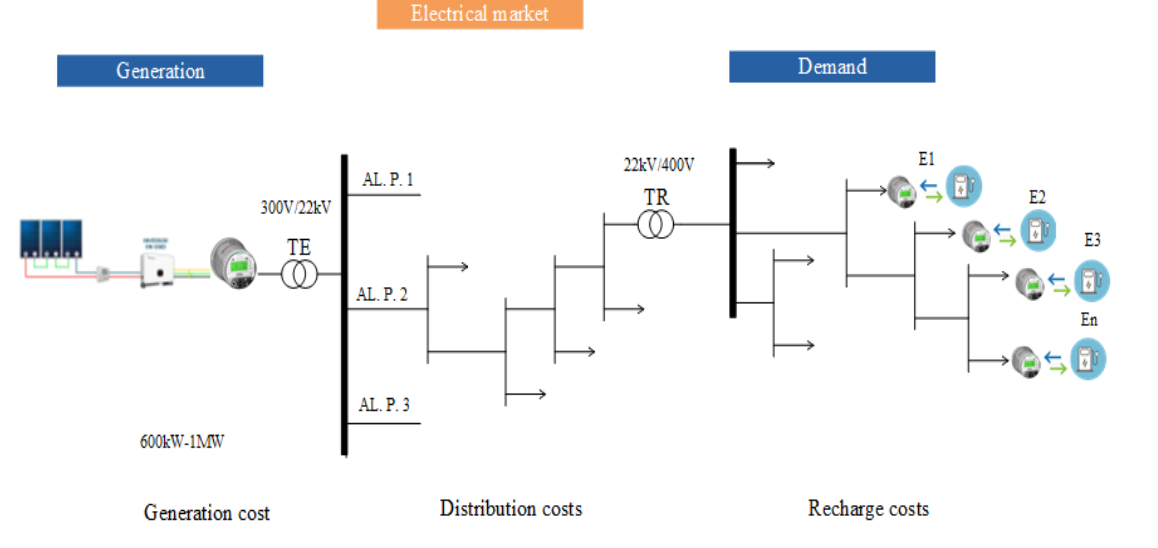
Figure 19. Analysis of costs by stage in the project. Table 8. Costs for recharging electrical energy with and without optimization.